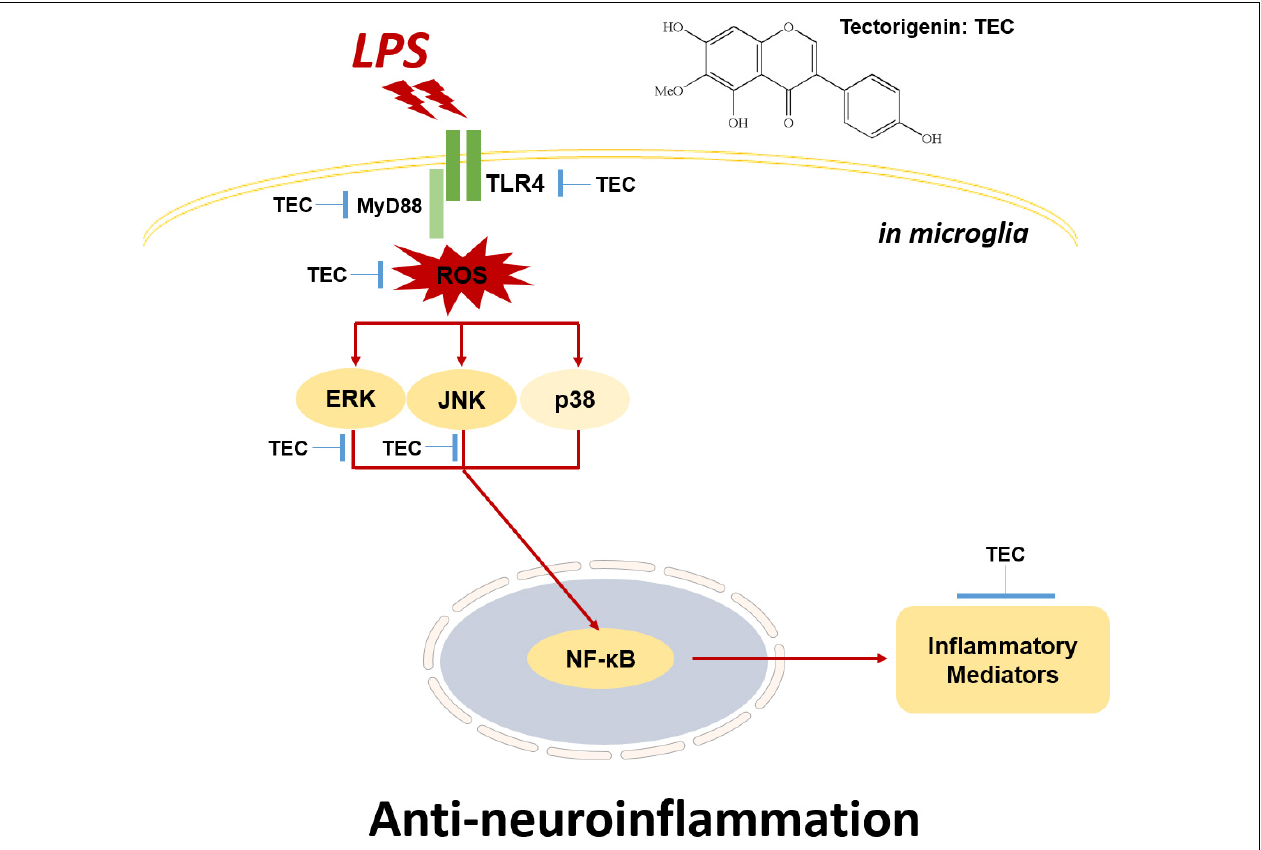
FIGURE 8 | Schematic model of the neuroinflammatory modulation afforded by TEC in activated microglia. TEC inhibits LPS-stimulated neuroinflammation through TLR4-MyD88-mediated NF- κ B and ERK/JNK pathways.